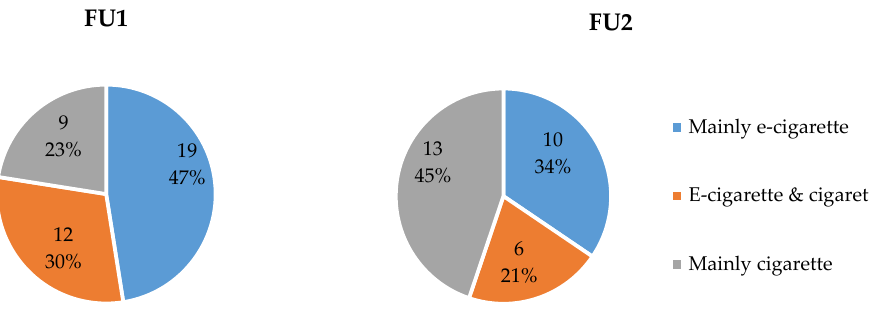
Figure 5. Distribution dual use at FU1 and FU2. Note: Proportion of cigarette/e-cigarette use was classified as “Mainly cigarette (e-cigarette)” as soon as reported proportion of cigarette (e-cigarette) use exceeded 60%; other responses were categorized as “E-cigarette & cigarette”.